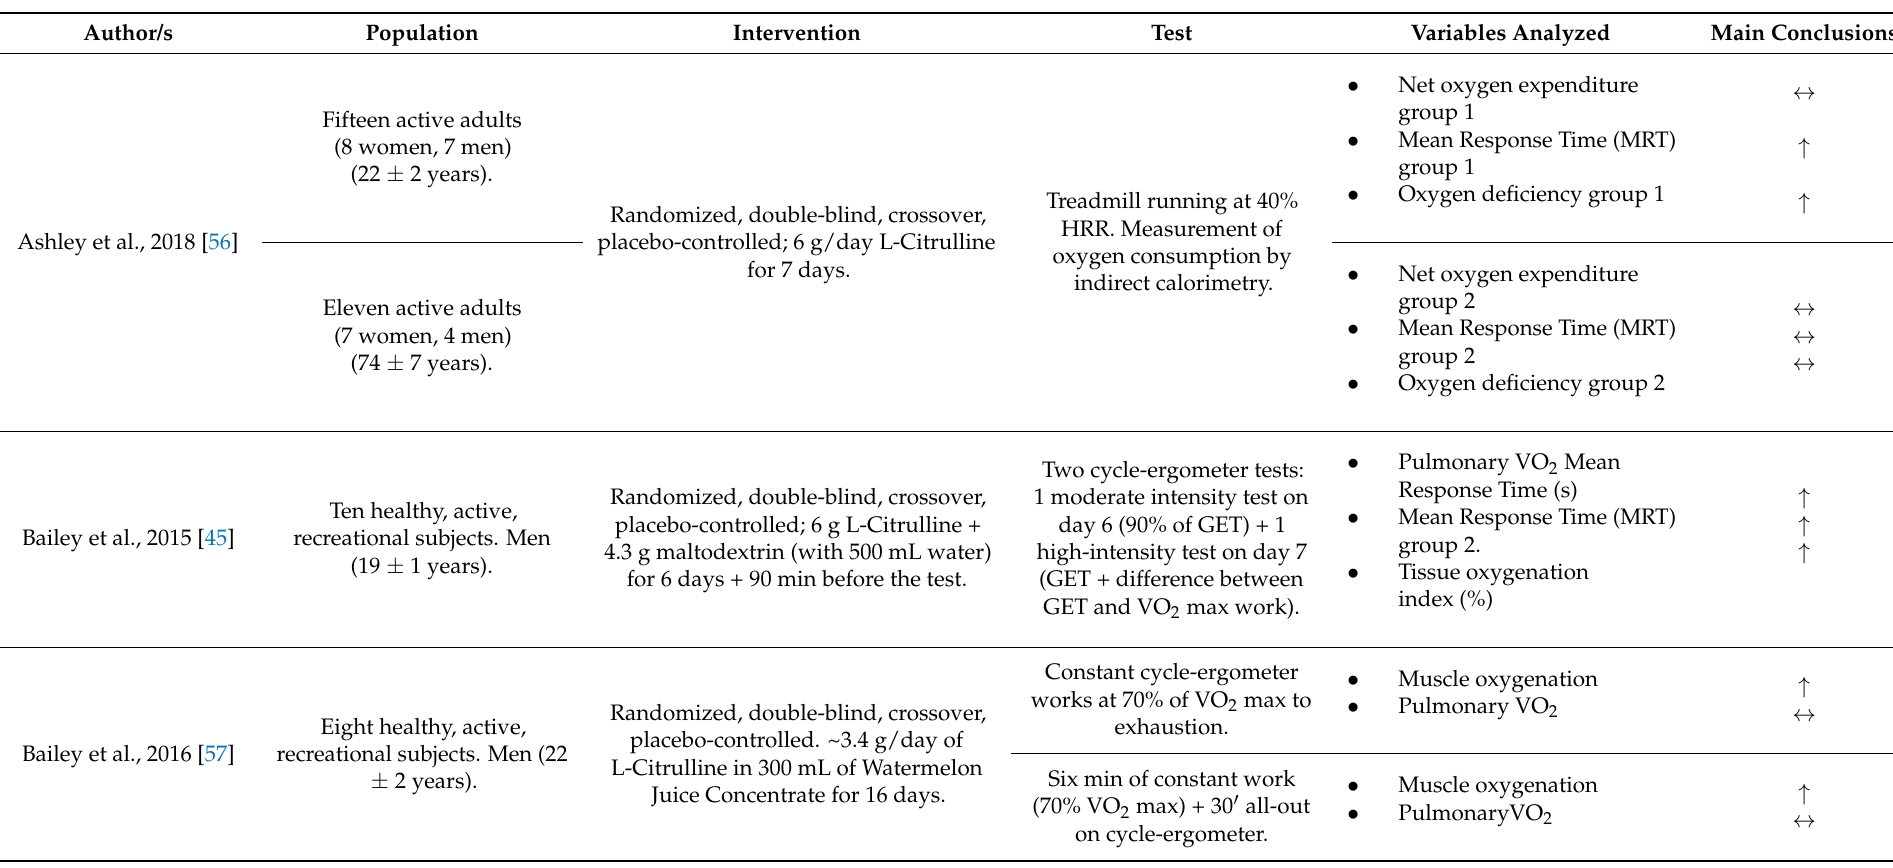
Table 4. Summary of studies included in the systematic review and meta-analysis investigating the effect of IAC on oxygen uptake kinetics (VO 2